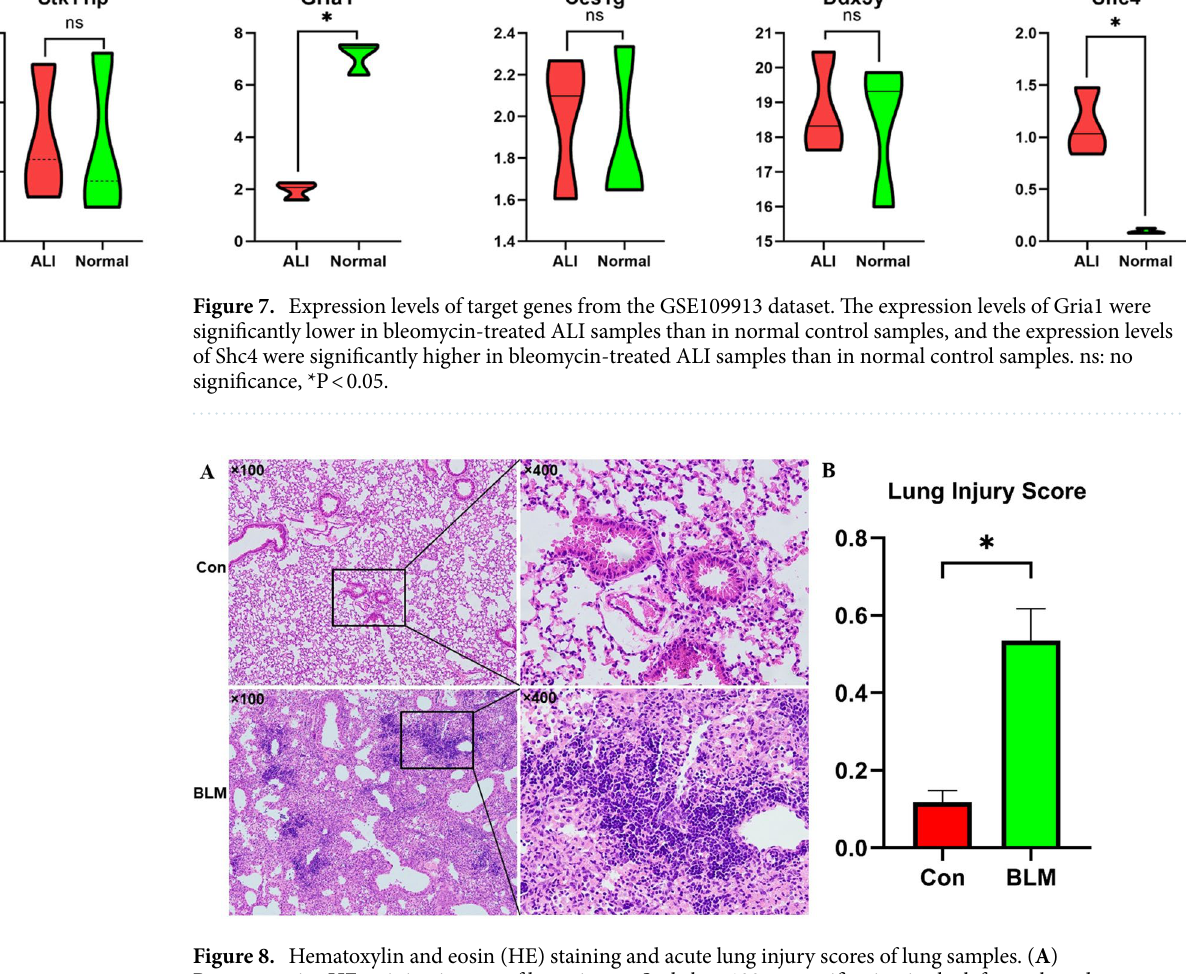
Figure 8. Hematoxylin and eosin (HE) staining and acute lung injury scores of lung samples. ( A ) Representative HE staining images of lung tissues. Scale bar, 100 × magnification in the left panels and 400 × magnification in the right panels. ( B ) The lung injury scores were calculated based on HE staining. n = 6 per group. *P <